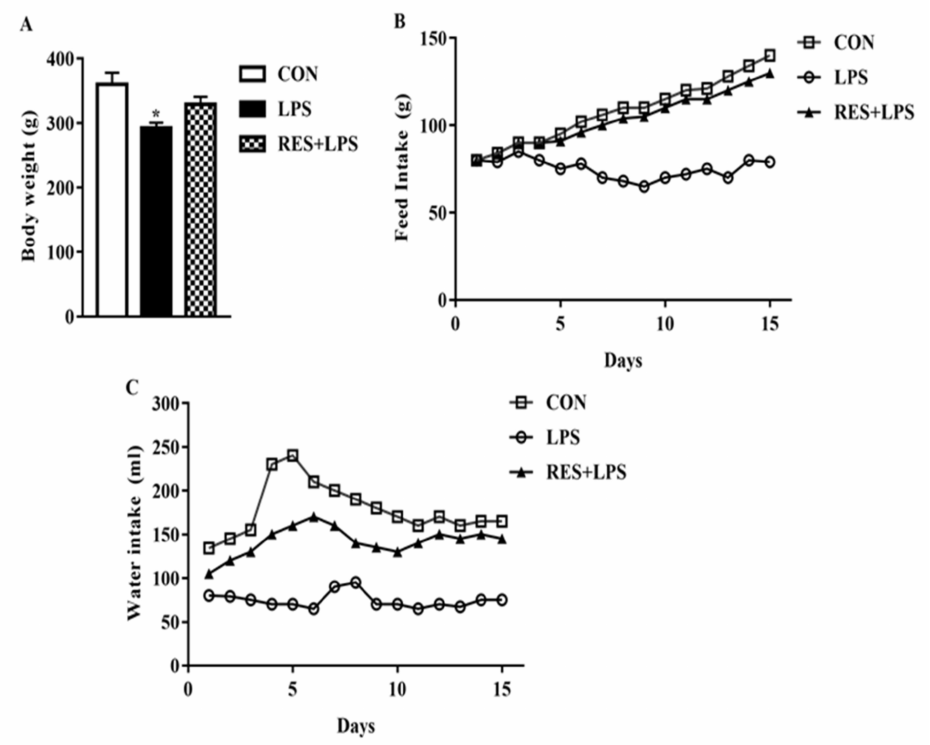
Figure 1. ( A ) Body weight, ( B ) feed intake, and ( C ) water intake of Control (CON), Lipopolysaccha- ride (LPS) and Resveratrol (RES) groups. Levels were significantly decreased in the LPS-fed group compared with the CON and RES+LPS groups. No significant difference was observed for the CON vs. LPS+RES group comparison. * p < 0.05, LPS vs.